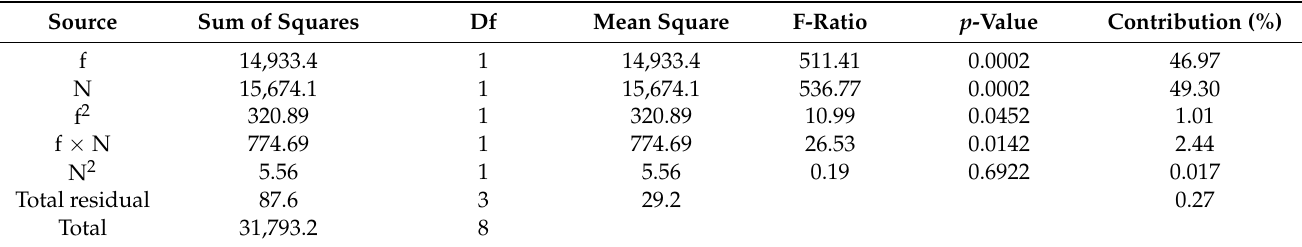
Table 4. Analysis of variance for Fz_PEEK-GF30.